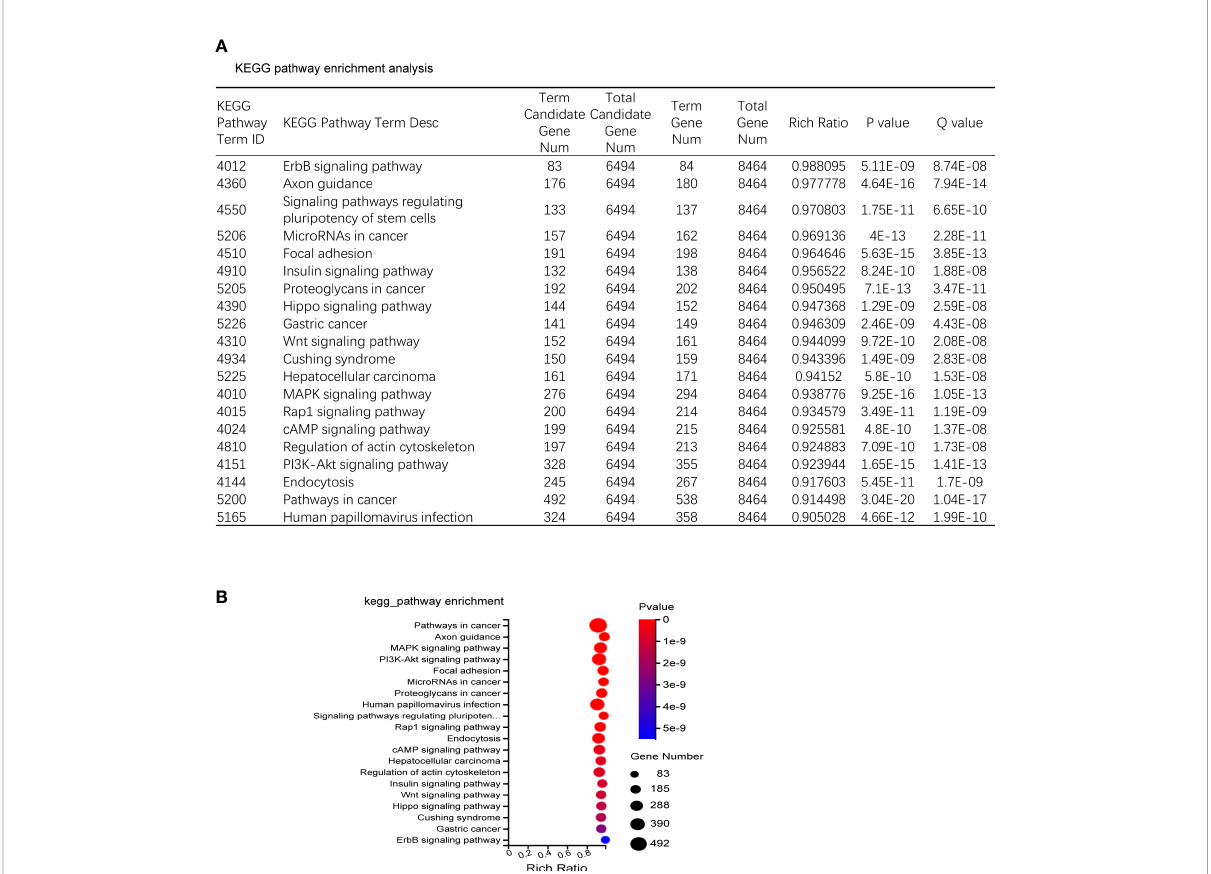
FIGURE 4 KEGG enrichment. (A) KEGG pathway sorted by enrichment ratio; Rich Ratio = Term Candidate Gene Num/Term Gene Num. (B) Enrichment bubble